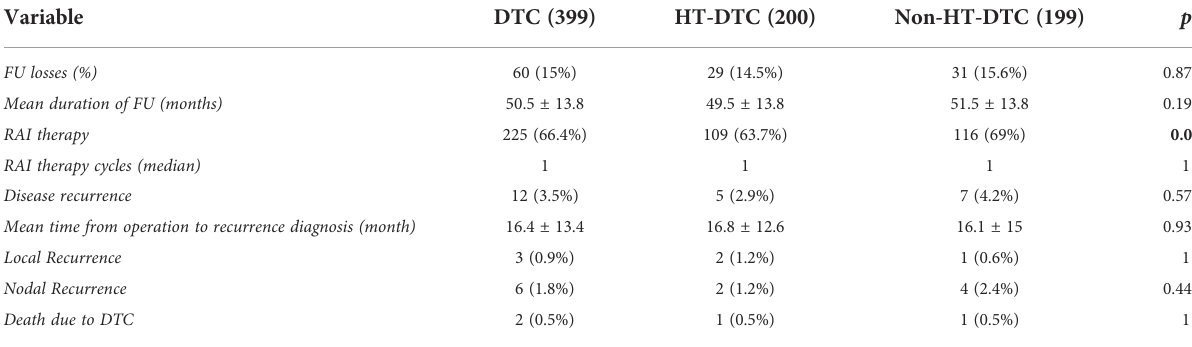
TABLE 5 Differentiated thyroid cancer follow-up.